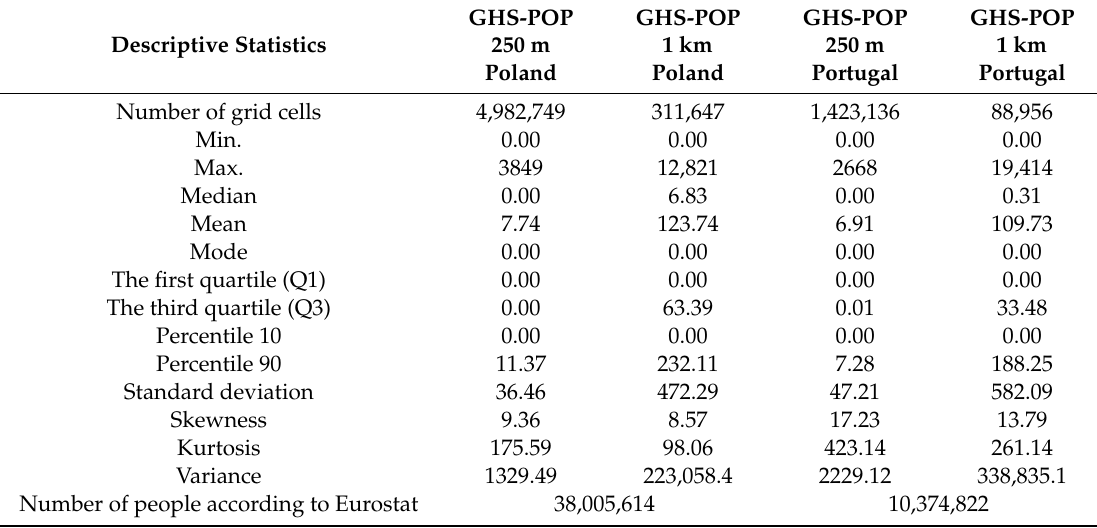
Table 1. Descriptive statistics of the GHS-POP for Poland and Portugal.